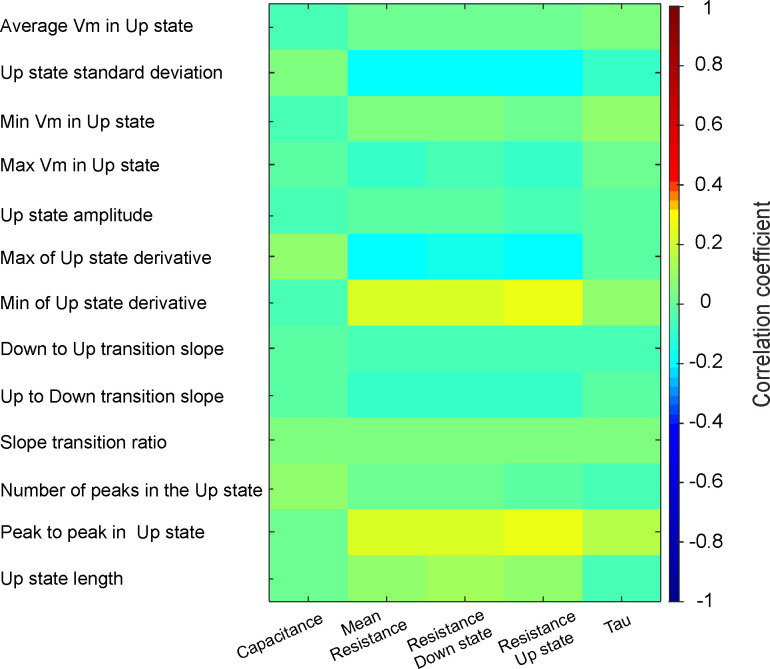
Correlation between the SWO features and electrophysiological properties of MSNs.Correlation coefficient of the 13 SWO features, showed in Figure 1 and the intrinsic properties of MSNs. Note that all coefficients are < 0.03.